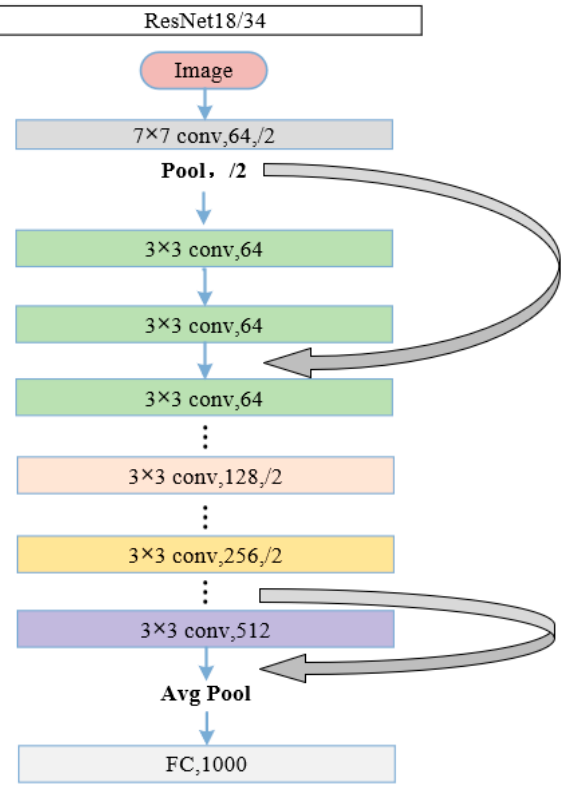
Figure 3. The framework of the proposed DLR model.